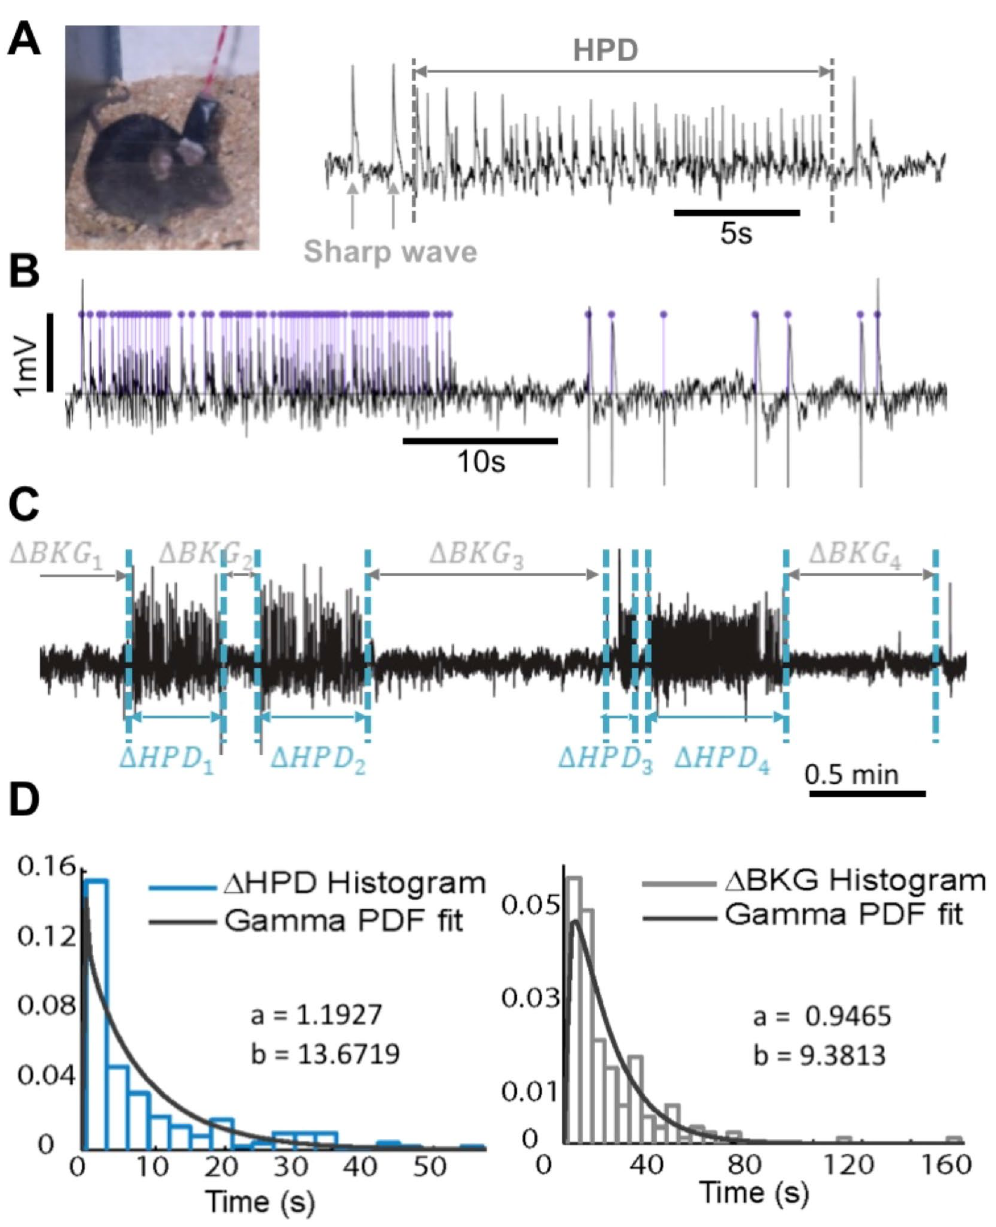
Figure 4. Determination of probability distributions for HPD characteristics. ( A ) Left : in vivo monitoring of KA mice. Right : Typical example of HPD, used in this study as a tissue hyperexcitability marker. ( B ) Example of HPD peaks detection. ( C ) Illustration of the variables used in identifying the probability distributions governing the occurrence rate, inter-HPD duration, and duration of HPD. ( D ) Probability laws fitted from experimental data used to identify the Input Noise Modulation Function are presented in Fig.